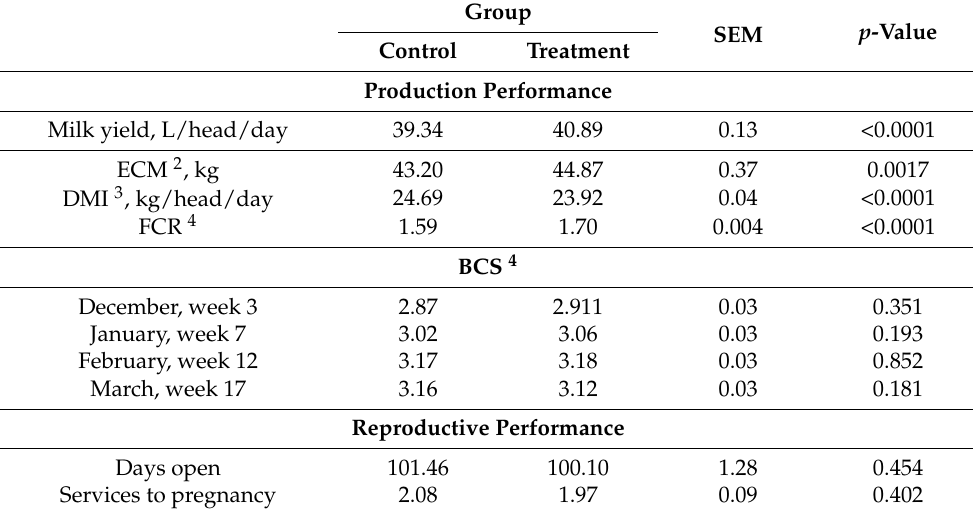
Table 2. Production performance: milk yield, feed intake, feed conversion rate, body condition scores, and reproductive performance in the two